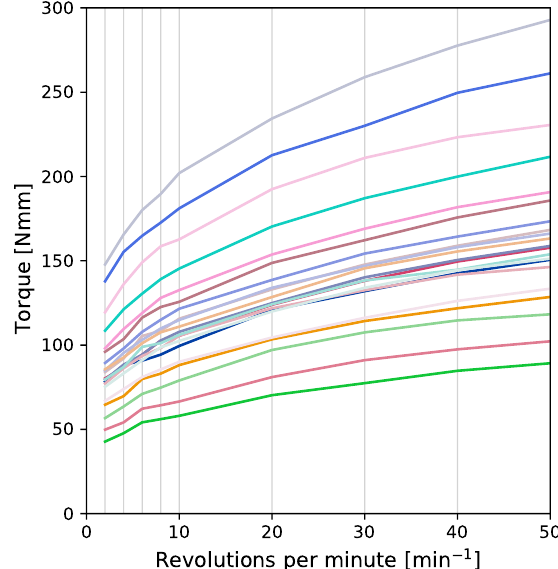
Figure 4. Plot of the flow curves generated in the rheometer. The different coloured lines show the measurements of the ultrasonic gel samples. The grey vertical lines show the points of the flow curve to be